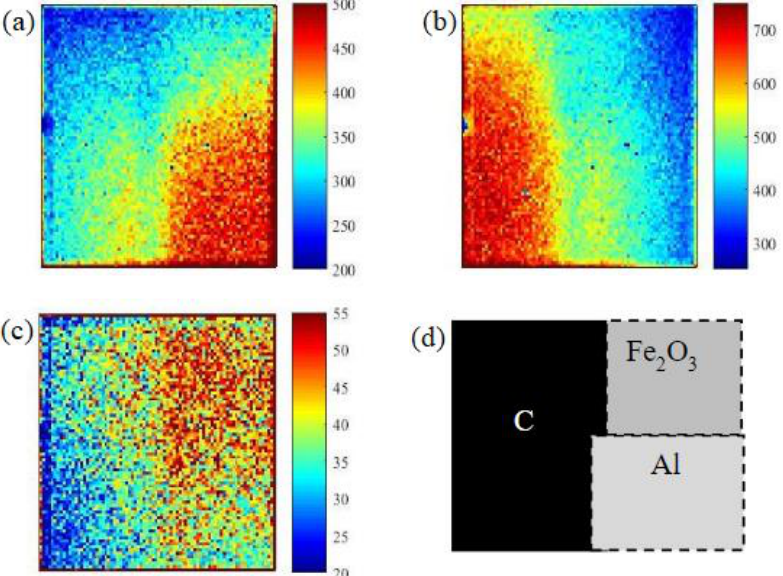
Figure 12. The number of events at ( a ) 66 keV (Aluminum), ( b ) 75 keV (Carbon) and ( c ) 131 keV (Oxygen), corresponding to the position of the material in the sample ( d ). Originally published in JPS Conf. Proc. 21, 011042 (2018). Reprinted with permission from Ref. [53] © 2018 The Author(s) of Ref. [53].